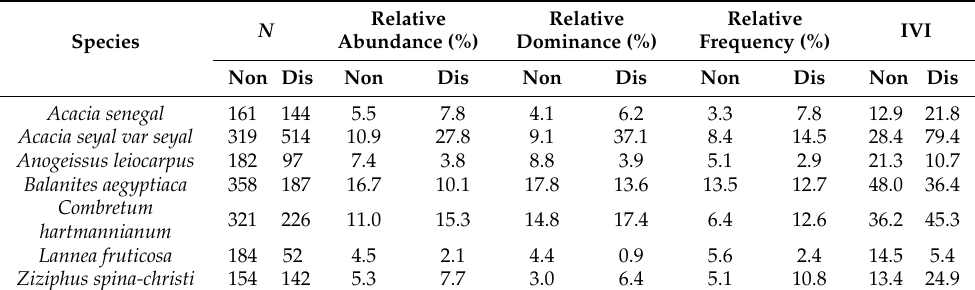
Table A3. Total number, relative abundance, dominance, frequency and the Importance Value Index calculated for each species per site (IVI) for the seven most frequently encountered tree species in non-disturbed and disturbed sites at the Dinder Biosphere Reserve, Sudan, during the assessment in February–April 2020. Non = Non-disturbed site; Dis = Disturbed site. Calculations were carried out for mature trees, seedlings and saplings of each species